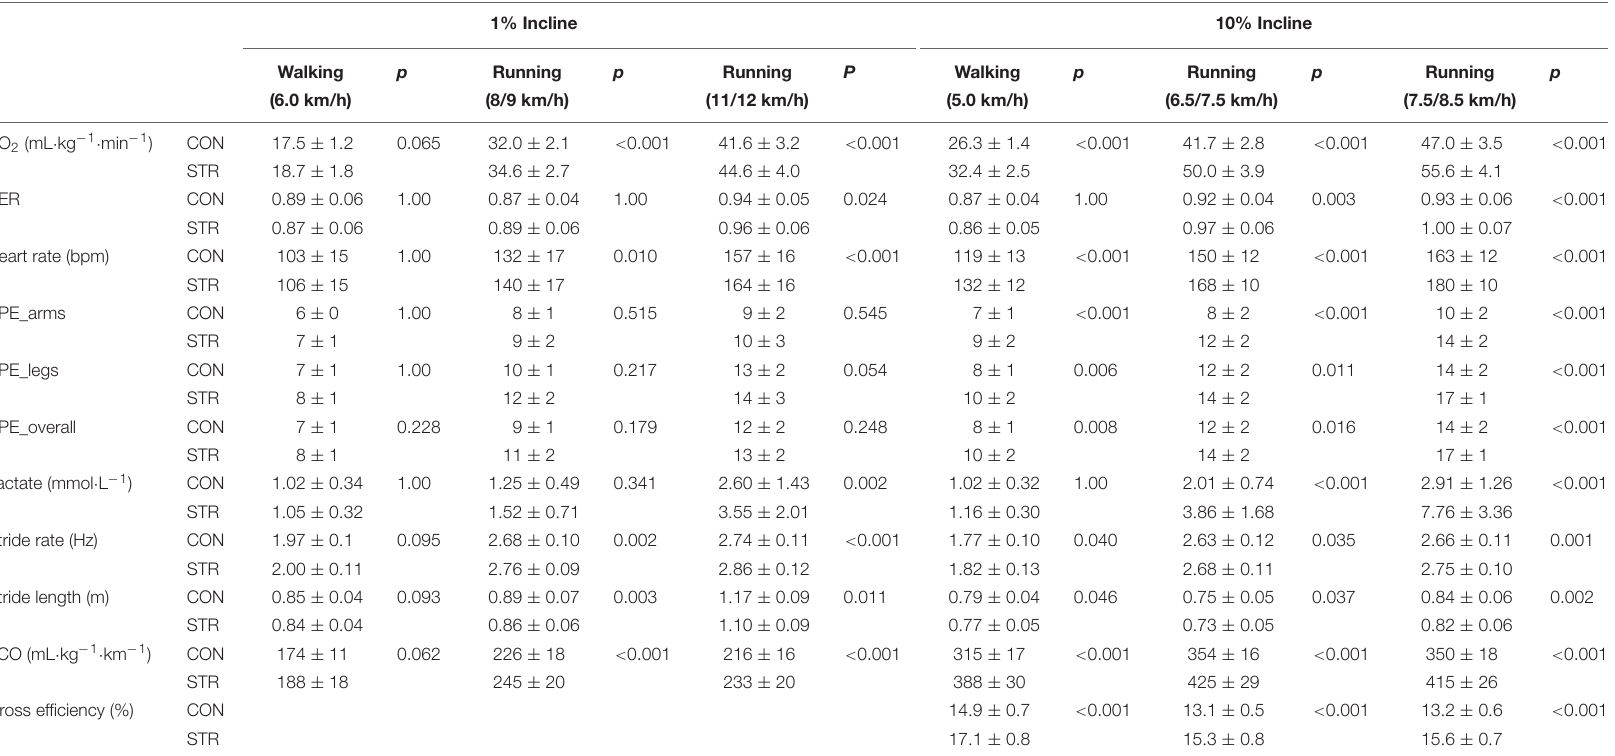
TABLE 3 | The physiological and kinematic behavior of men and women pooled while walking or running with and without a